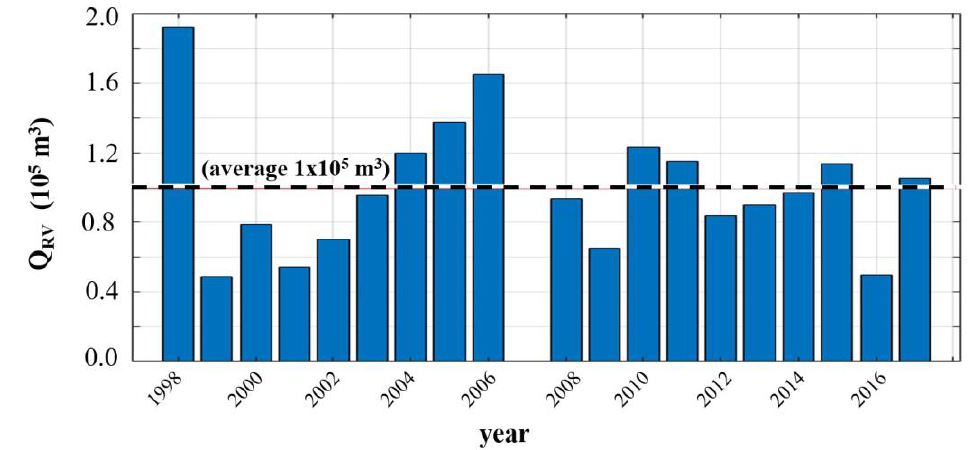
Figure 6. Temporal variations in the sediment discharge from Tedori River during 1998 to 2017. For the whole period, the average sediment discharge was estimated to be 10 × 10 4 m 3.